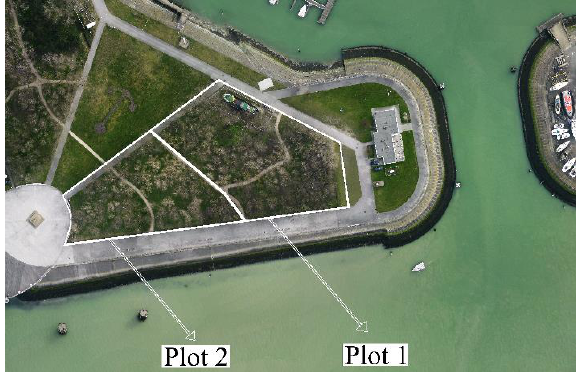
Figure 10. Aerial image of the study areas (Plot 1 and Plot 2) A general view of part of the results is presented in Fig. 11.